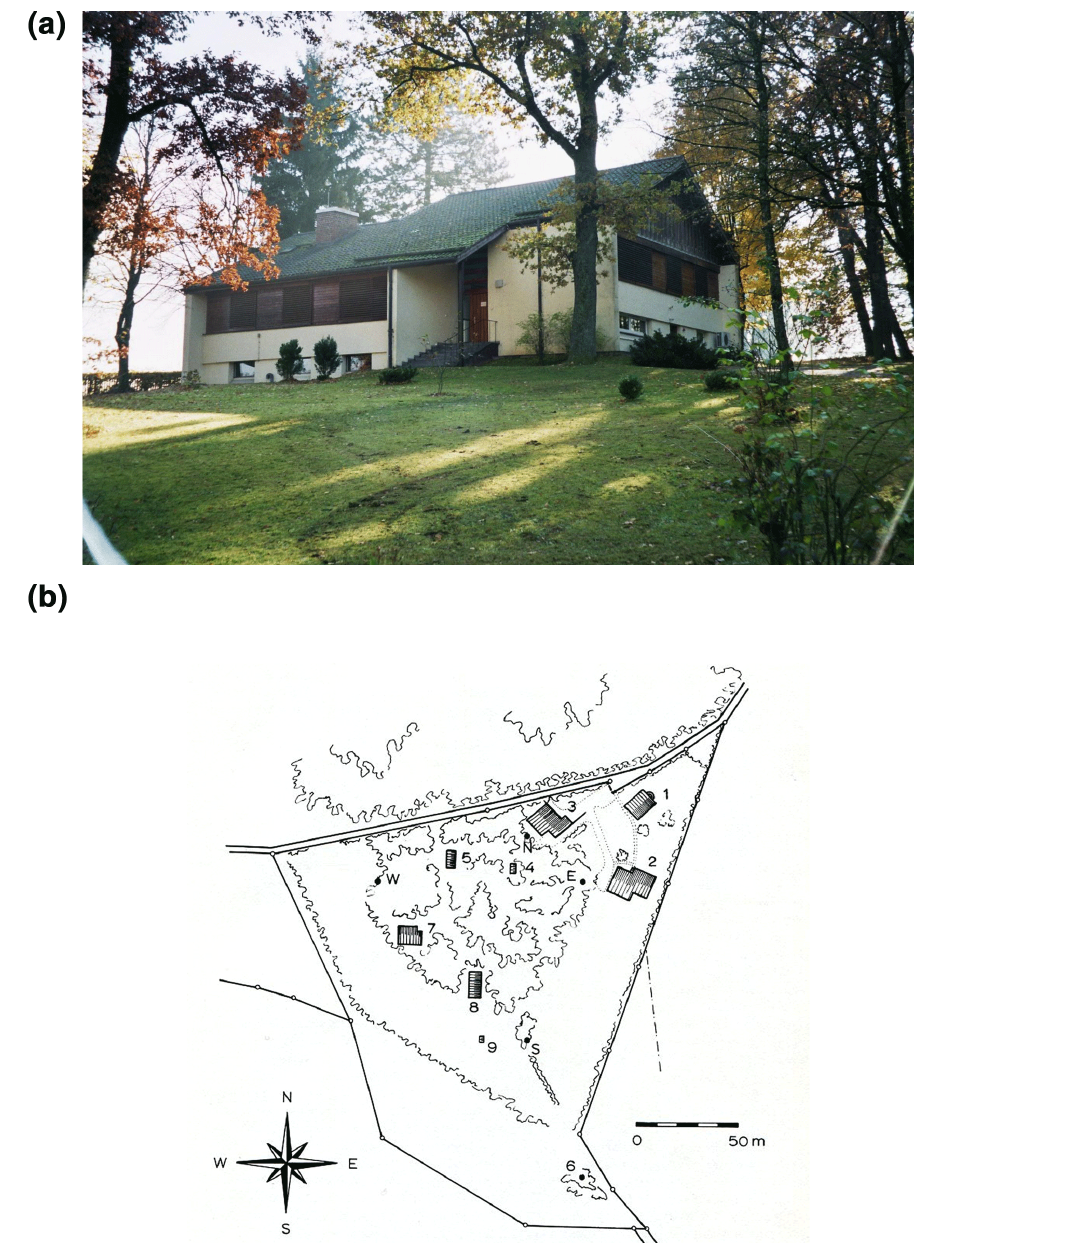
Figure 16. (a) The new main building of the observatory, finished in 1963. (b) Actual plan of the observatory. (1) Main building from 1938. (2) Main building from 1963. (3) Garage and archive. (5) Maisacher Hütte. (6) Bunker for the seismometers. (7) Variationshaus. (8) Absoluthaus. (9) Chronograph house. E–W and N–S: end points of lines to measure potential